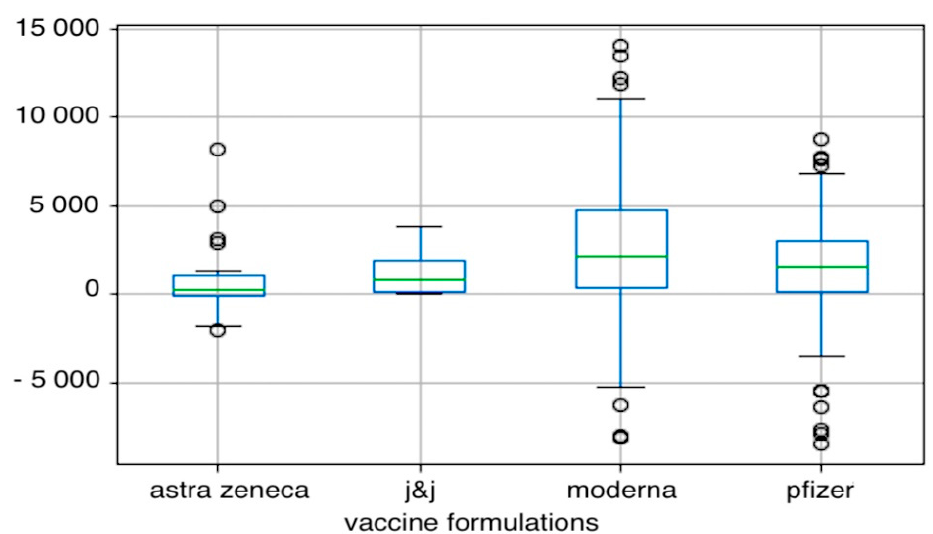
Figure 1. The figure shows the difference in antibody levels after the administration of the second dose of the individual vaccine formulations [IU/mL]. J&J-Johnson&Johnson. The main body of the boxplot shows the quartiles, horizontal lines in the middle of each box are medians, whiskers is the vertical lines extending to the most extreme, non-outlier data points and fliers represent data that extend beyond the whiskers.